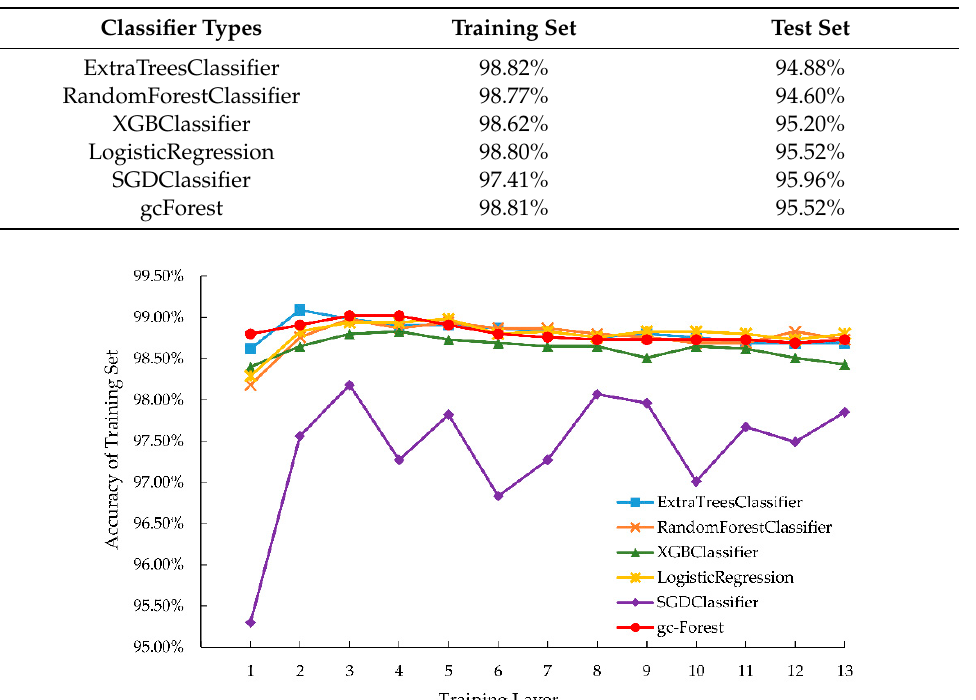
Figure 11. Training set classification accuracy of gcForest and its built-in classifiers in each layer.